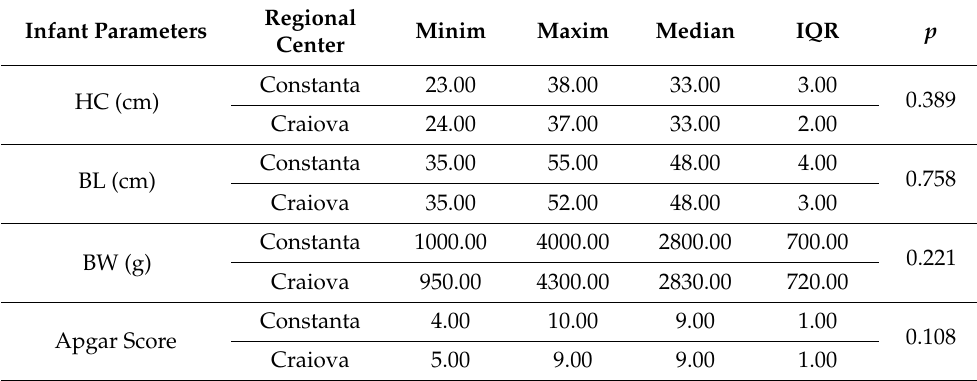
Table 2. Anthropometric parameters and Apgar score of HIV-negative newborns.